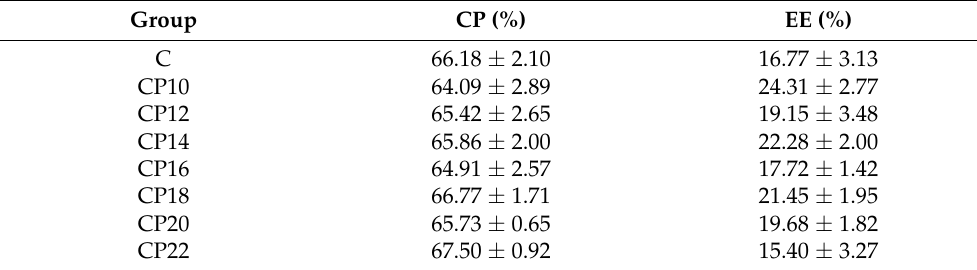
Table 5. Crude protein and ether extract of BSF larvae in Experiment